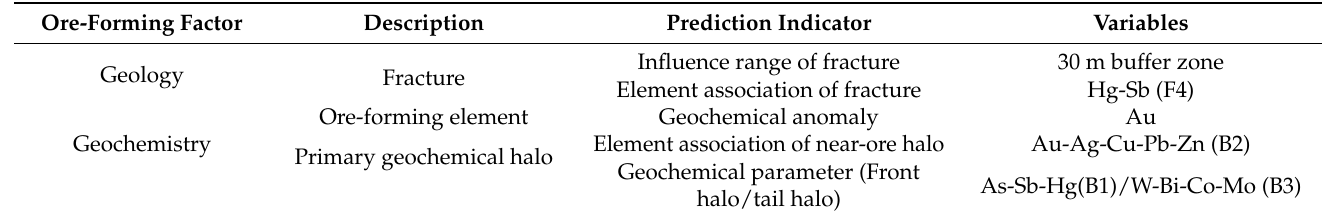
Table 3. Geological and geochemical quantitative mineral resource prediction model at depth of Zaozigou gold deposit.